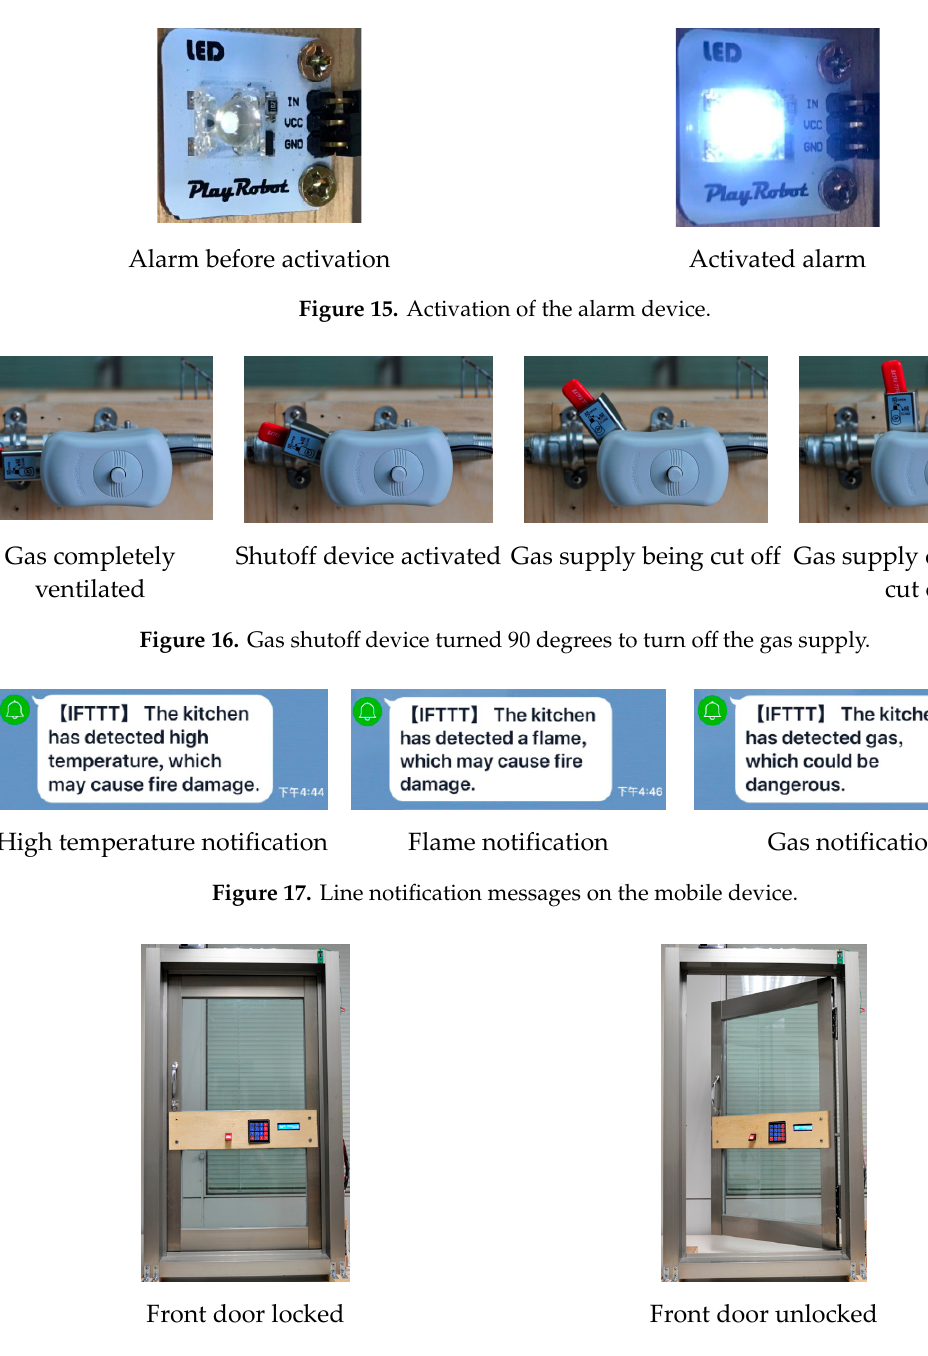
Figure 14. Changes of gas concentration, light intensity and temperature.